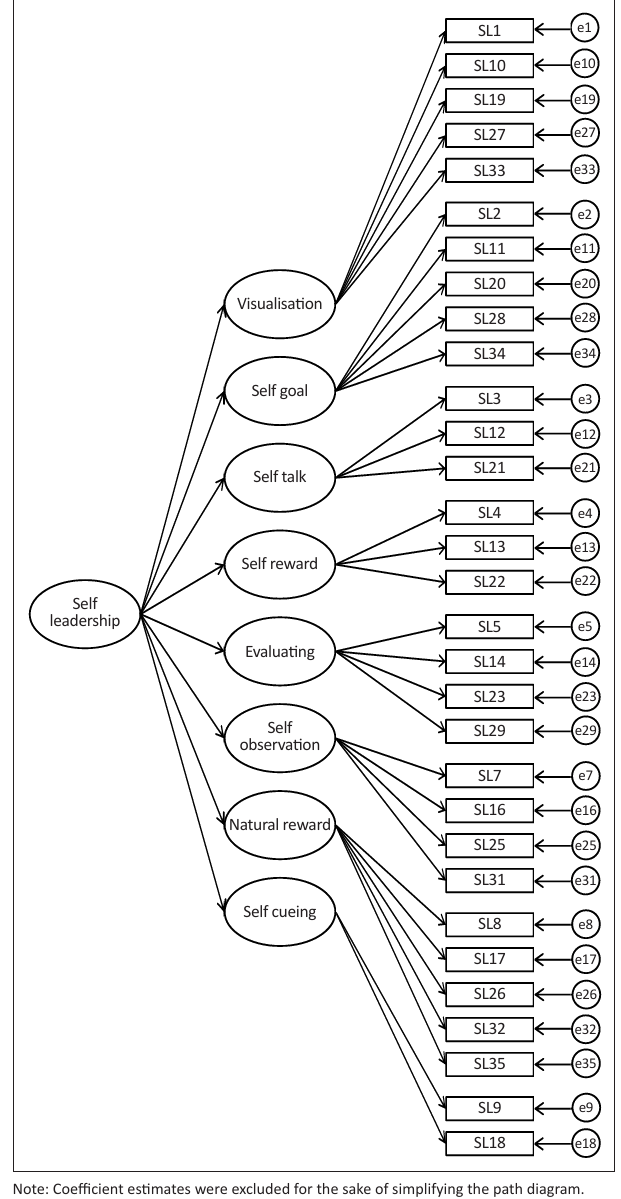
FIGURE 1: The RSLQ second-order confirmatory factor analysis path diagram indicating eight first-order factors loading onto a single second-order self-leadership